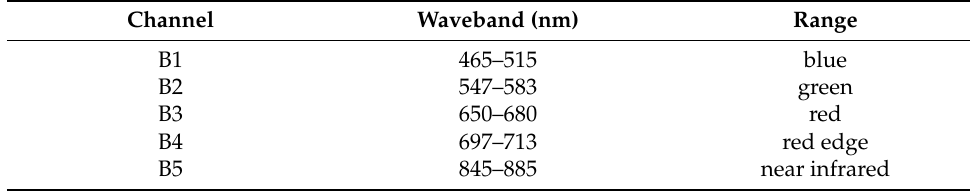
Table 1. Planet channel wavelengths.